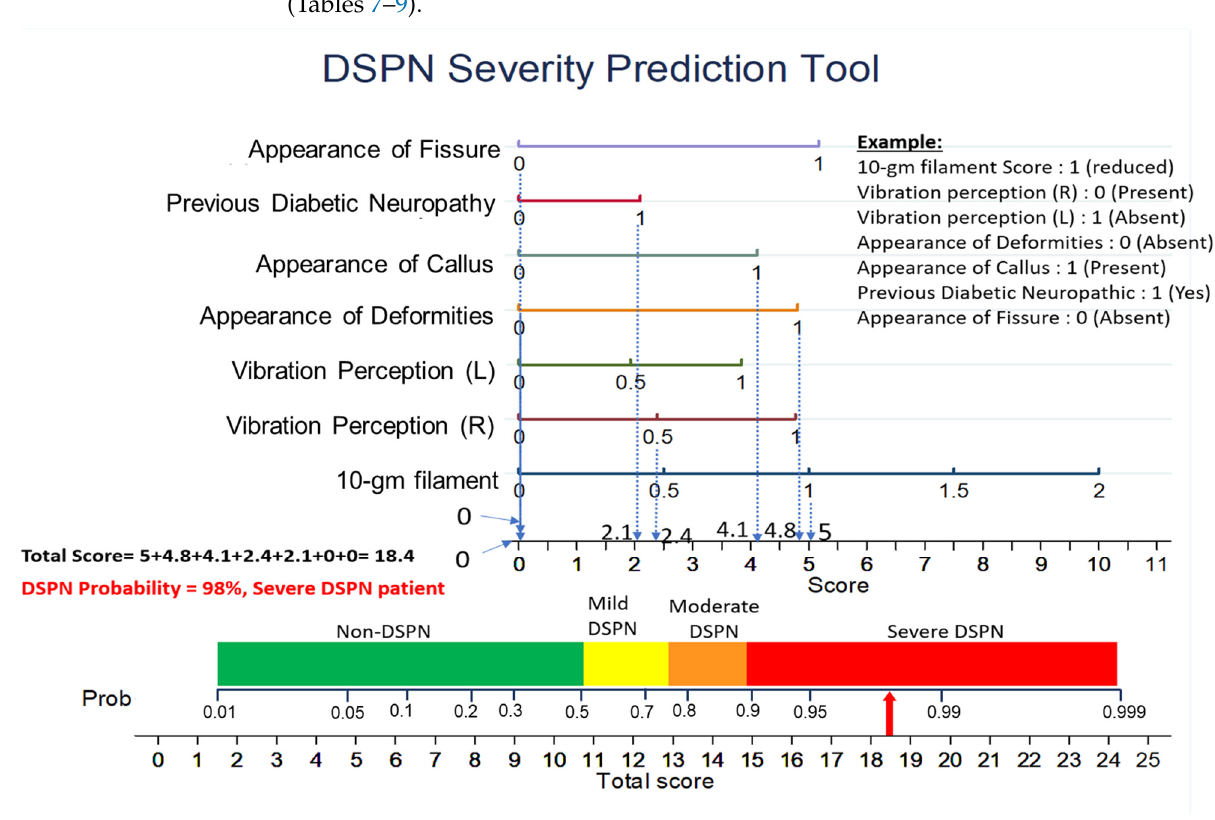
Table 6. MNSI severity score from the nomogram and the corresponding severity probability of the DSPN patient.